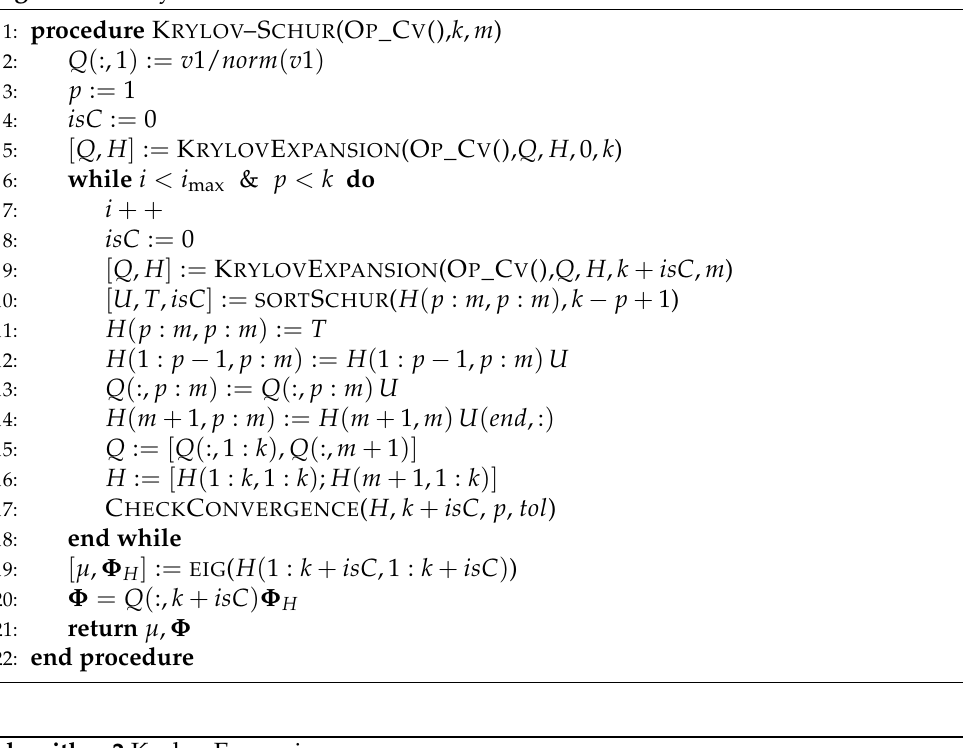
Algorithm 1 Krylov–Schur